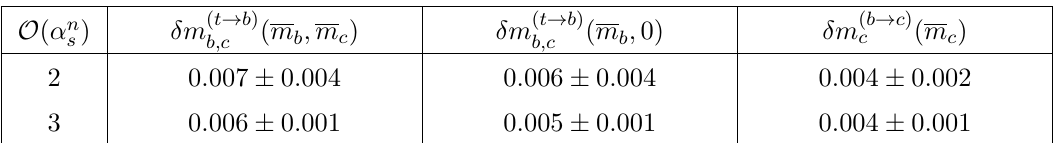
Table 4 . The top-bottom MSR-MS mass matching corrections, given in units of GeV, for (cid:12)nite bottom and charm masses (second column), for (cid:12)nite bottom quark mass and massless charm quark (third column), and the bottom-charm MSR-MS mass matching correction (fourth column). For the (cid:12)nite masses of the top, bottom and charm quarks the values ( m t ; m b ; m c ) = (163 ; 4 : 2 ; 1 : 3) GeV are used. The uncertainties are obtained from variations of the renormalization scale in the range m b (cid:20) (cid:22) (cid:20) m t for (cid:14)m ( t ! b ) and in the range m c (cid:20) (cid:22) (cid:20) m b for (cid:14)m ( b ! c ) c . The central values are the b;c respective mean of the largest and smallest values obtained in the scale